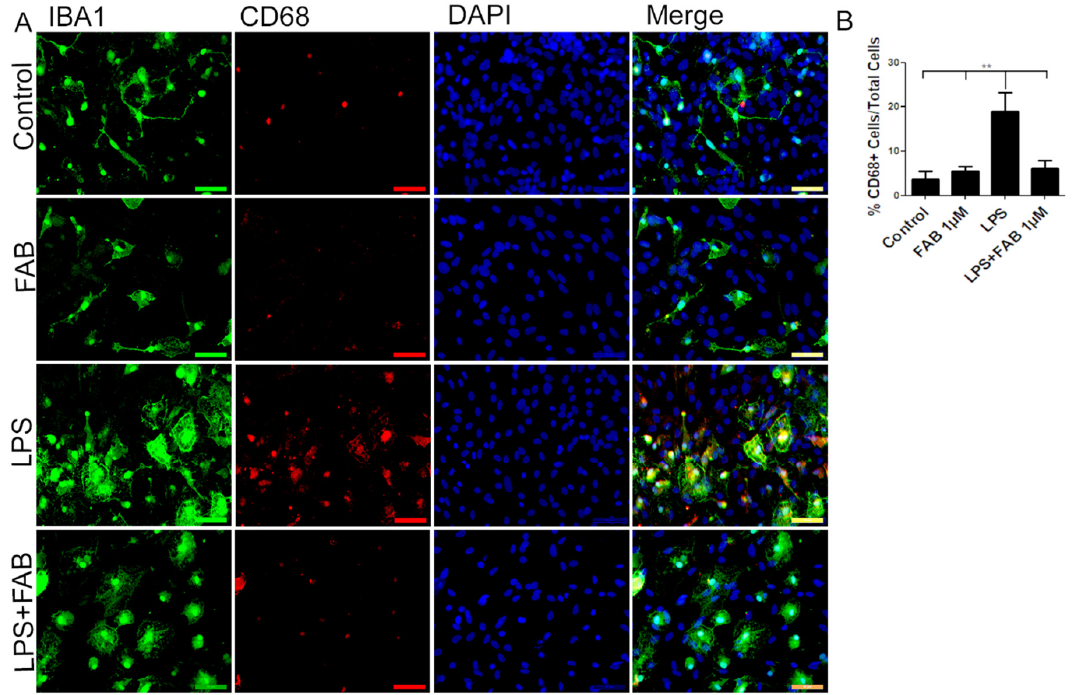
Figure 3. Agathisflavone exerts an anti-neuroinflammatory effect against damage induced by LPS. ( A ) Representative photomicrographs of immunocytochemistry for Iba-1 (green) and the M1 microglial marker CD68 (red) counterstained with DAPI (blue) in cocultures; scale bar: 50 µm. ( B ) Bar graph showing the percentage of CD68 + /Iba-1 + cells in each treatment group; values are expressed as the mean ± SEM ( n = 3) and were tested for significance by one-way ANOVA. ** p < 0.01.